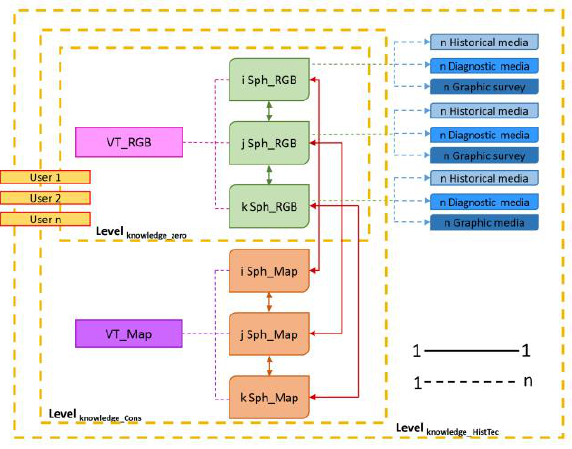
Figure 2. Logical - technical flowchart applied in the Phase